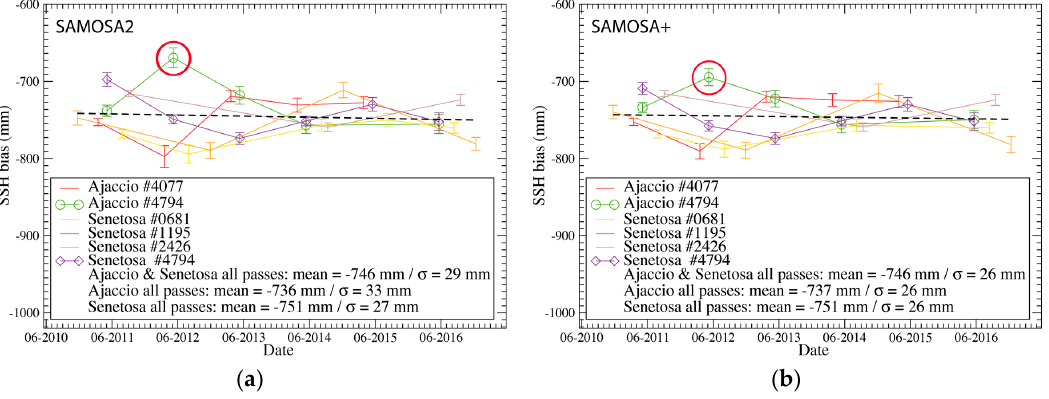
Figure 9. Time series of the CryoSat-2 SSH biases for each pass and the averages from Ajaccio, Senetosa and both (dash black line): ( a ) corresponds to the G-POD standard retracking (SAMOSA2) while ( b ) corresponds to the improved retracking (SAMOSA+) tuned for coastal, inland waters and ice.